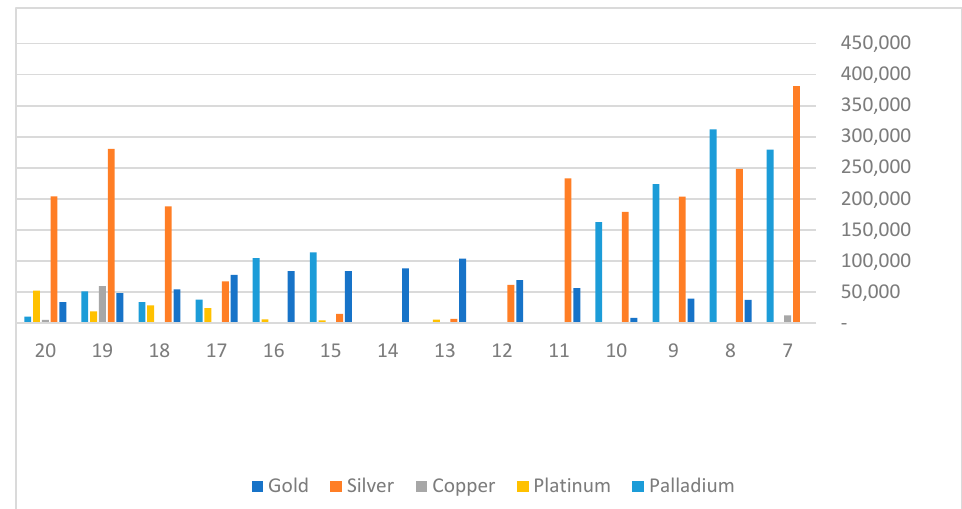
Figure 6. Net profits trading results of Bollinger bands strategy.